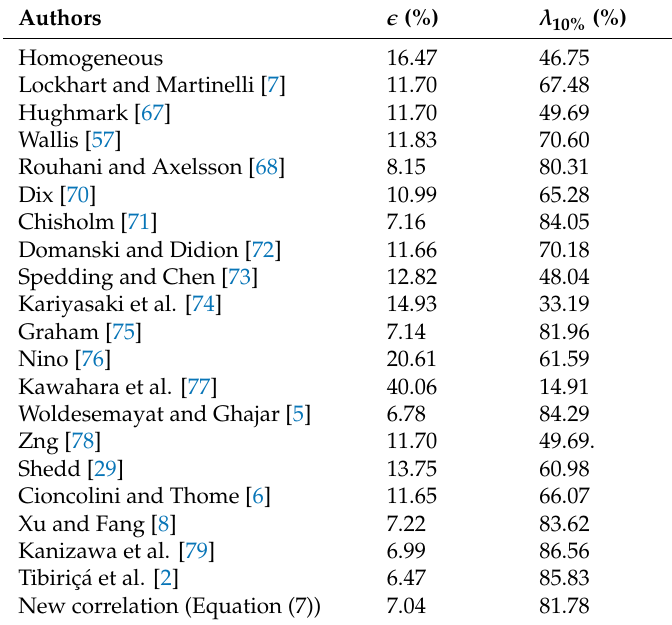
Table 8. Mean absolute error and the percentage of macrochannel data with error up to 10% for the correlation evaluated.